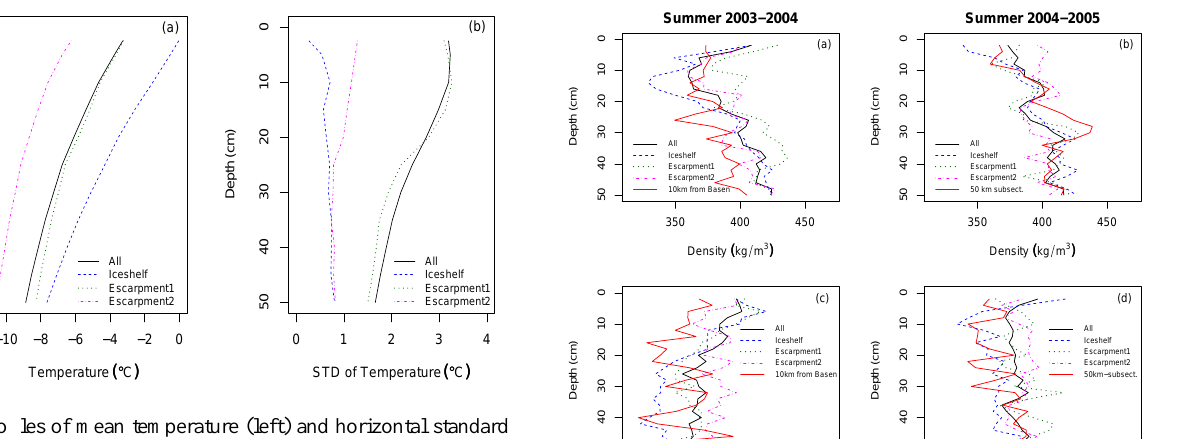
Fig. 8. Profiles of mean temperature (left) and horizontal standard deviation of temperature (right) from the 310km transect (from the entire transect and from separate sections of the transect) during the season 2004/2005.